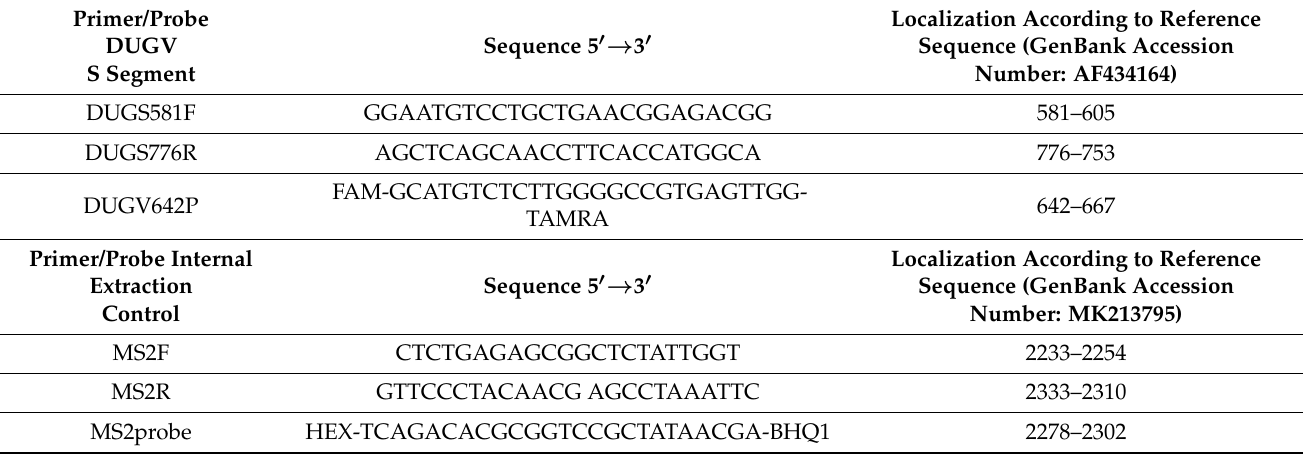
Table 1. Sequences of primers and probes used for the detection of Dugbe orthonairovirus (DUGV) genome. Primer/Probe DUGV S